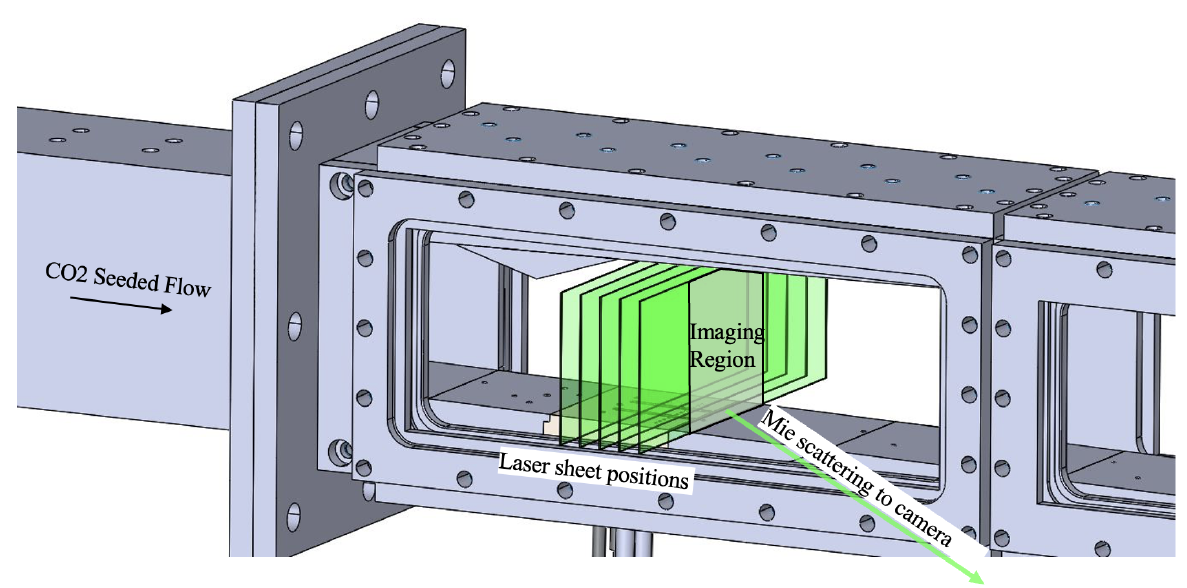
Figure 3. Overview of crossflow Mie scattering setup. Images of Mie scattering by CO 2 condensation are recorded at a shallow angle through side